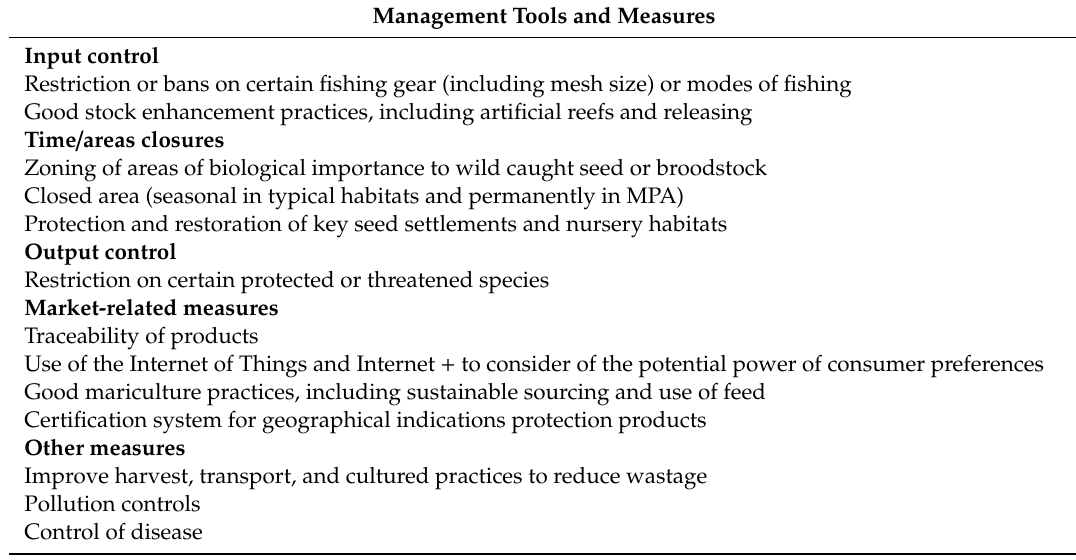
Table 2. Management tools and measures for the di ff erent components of marine